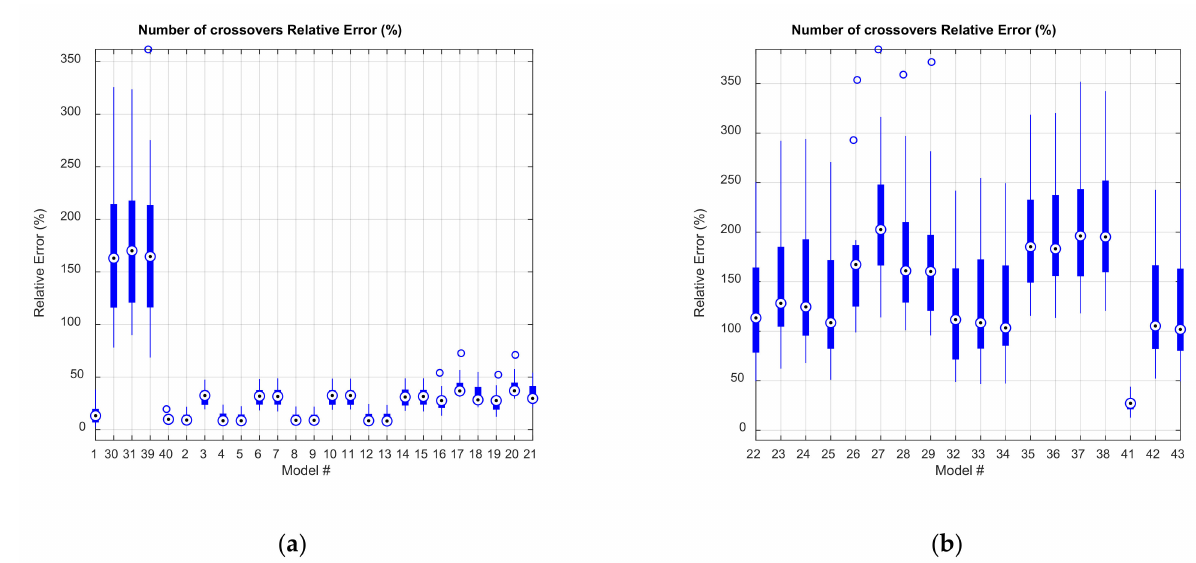
Figure 10. Median relative errors on the number of crossover distortions. ( a ) Models without vertical springs at the base; ( b ) models with vertical springs at the